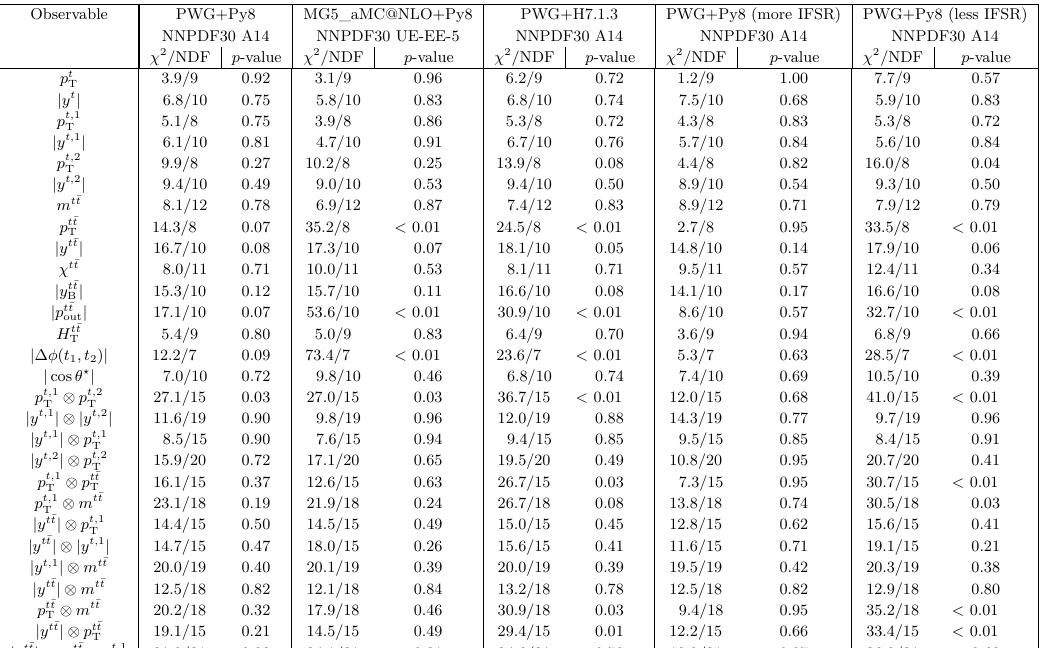
Table 4 . Comparison between the measured normalized particle-level fiducial phase-space differ- ential cross-sections and the predictions of several MC event generators. For each observed and predicted differential cross-section, a χ 2 and a p -value are calculated using the covariance matrix described in the text, which includes all sources of uncertainty in the measurement. The uncertainty in the prediction is not included. The number of degrees of freedom (NDF) is equal to N b − 1 , where N b is the number of measured values in the distribution.